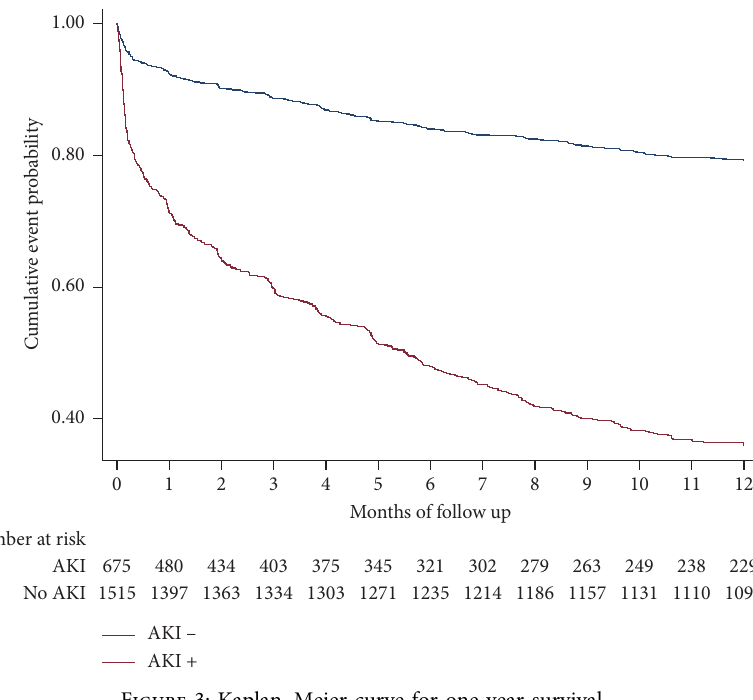
Figure 3: Kaplan–Meier curve for one year